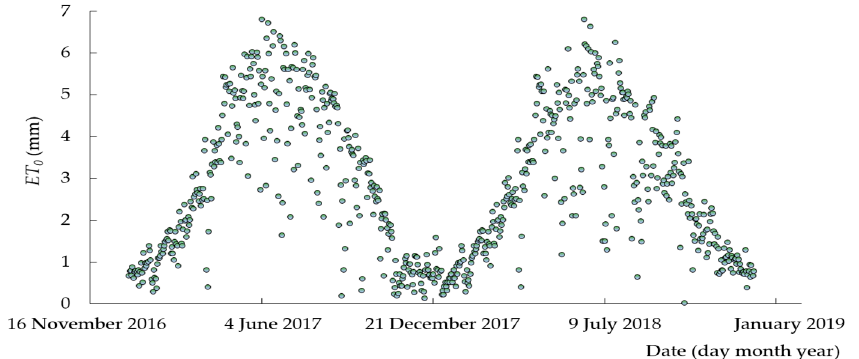
Figure 8. ET 0 calculated with Penman–Monteith equation in 2017–2018.